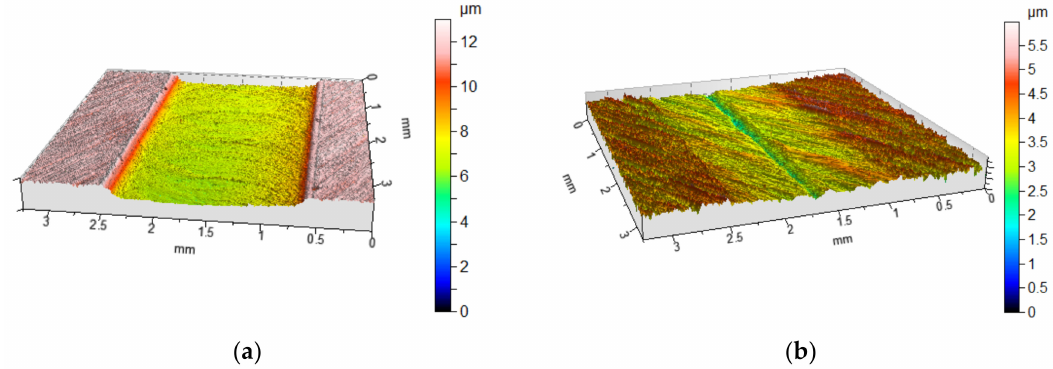
Figure 3. Isometric view of a surface created: ( a ) using a sharp mill cutter with sharp edges from both sides and ( b ) made with the use of a ball mill cutter.